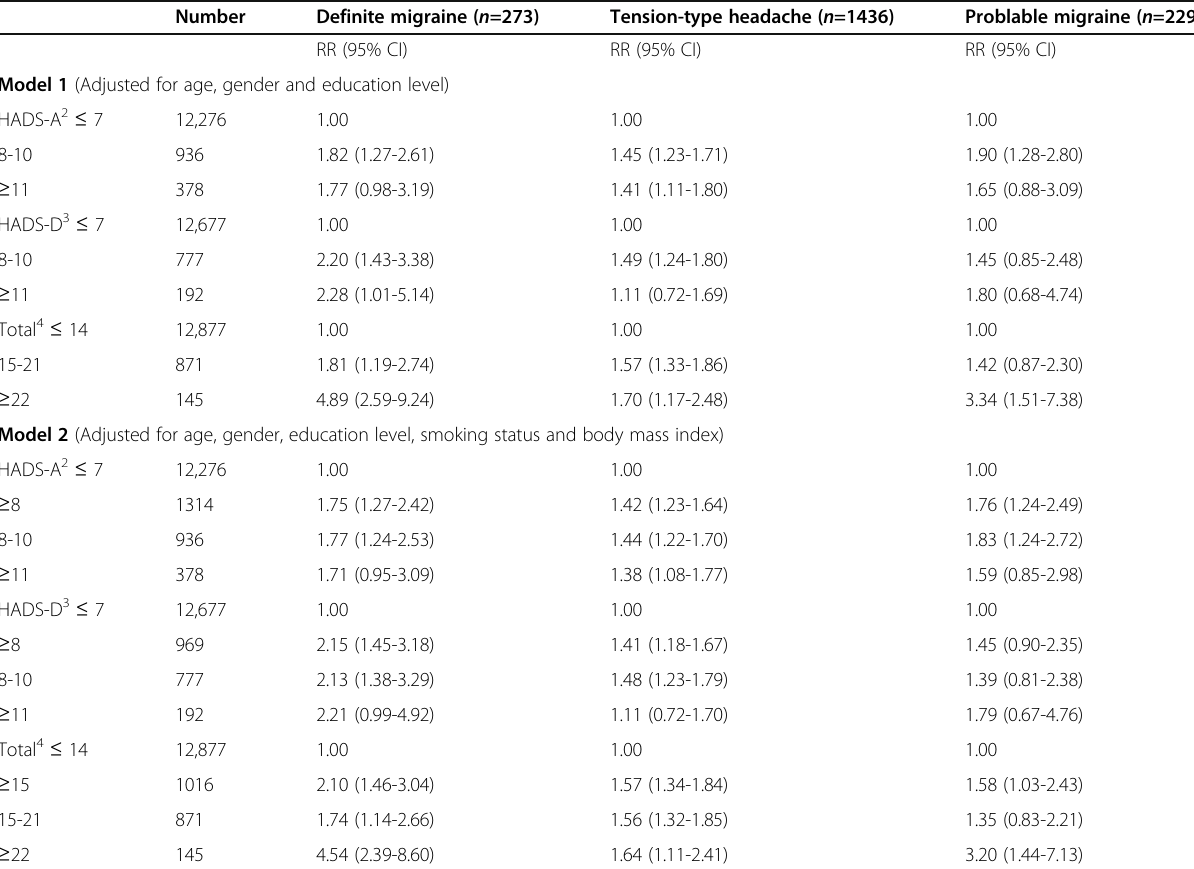
Table 2 Headache free individuals in HUNT3 ( n =13,893): Risk of migraine and tension-type headache in HUNT4 based on HADS 1 score categories in HUNT3 evaluated by poisson regression with 95% confidence interval Number Definite migraine ( n =273) Tension-type headache ( n =1436)